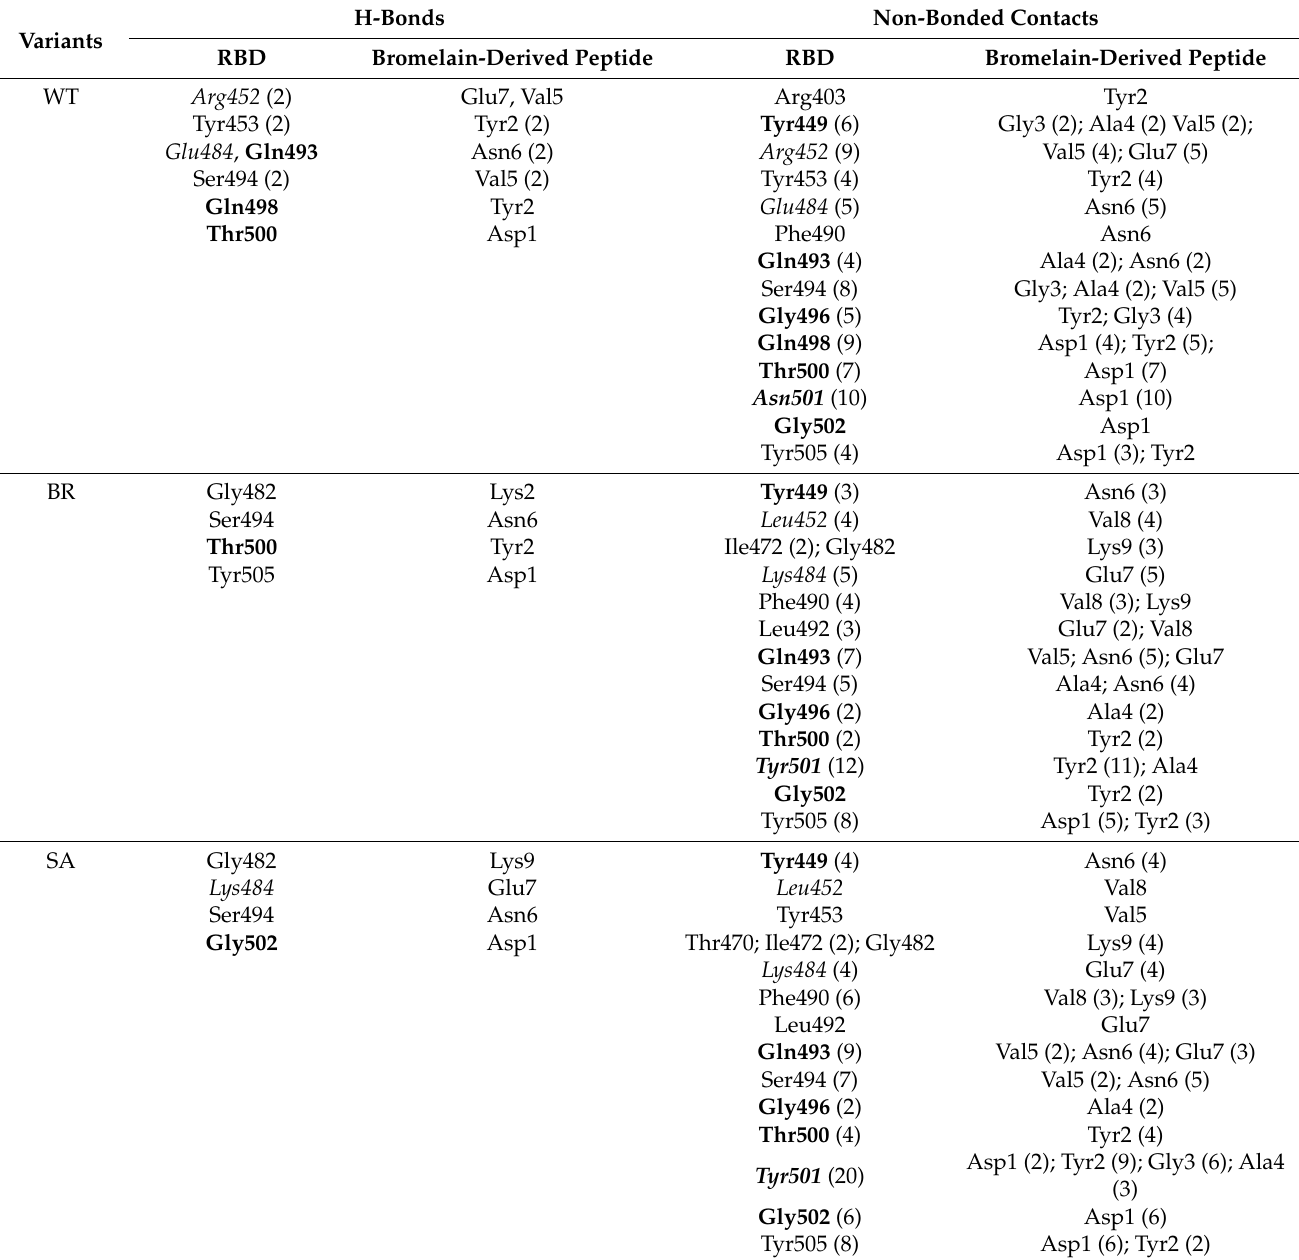
Table 3. List of interacting amino acids between RBDs and bromelain-derived peptide. The position of the interacting residues in pocket and mutation sites are indicated in italics, while the key amino acid residues that play a role in binding RBD to hACE2 are marked in